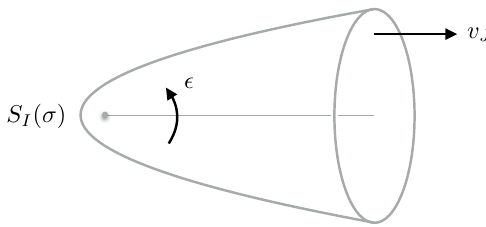
Figure 3. Wavefunctions of spin chain eigenstates from A -twisted cigar partition functions.